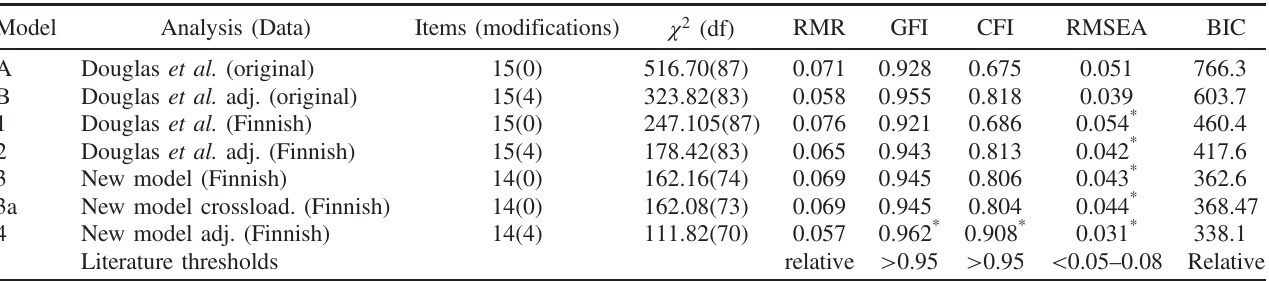
TABLE II. Model fit indices for the CFA models by Douglas et al. [11] (model A – B) and the models based on the Finnish